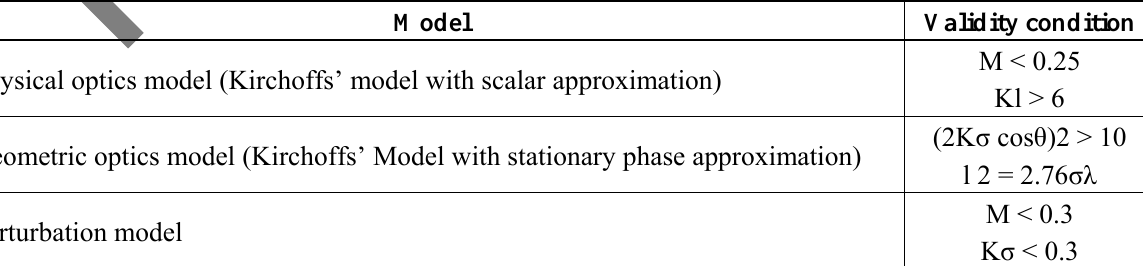
Table 1. Validity conditions for different